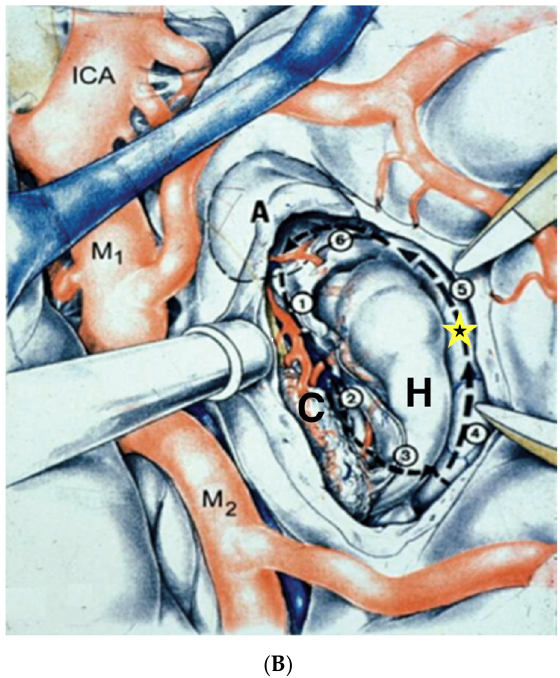
Figure 3 . Reprinted and Modified by permission from Springer Nature: Adv Tech Stand Neurosurg, Ya ş argil MG, Teddy PJ, Roth P. Selective amygdalohippocampectomy: operative anatomy and surgical technique. Copyright, 1985 [55]. ( A ) The Sylvian fissure is opened widely to expose the inferior delineation of the insula called the circular sulcus with the planned white matter incision marked in a dashed line between two middle cerebral opercular temporal arteries; ( B ) Surgeon’s view into the opened ventricle illustrating the choroid plexus (C), hippocampus (H), collateral eminence (star), middle cerebral vessels (M1 and M2), and amygdala (A). Numbers represent steps in the extra ‐ pial removal of mesial temporal structures: coagulation and division of the hippocampal vessels (steps 1 and 2), disconnection of the hippocampal body from the hippocampal tail (step 3), opening the collateral eminence to empty and remove the parahippocampus (steps 4 and 5), and remove uncus and amygdala (step 6).